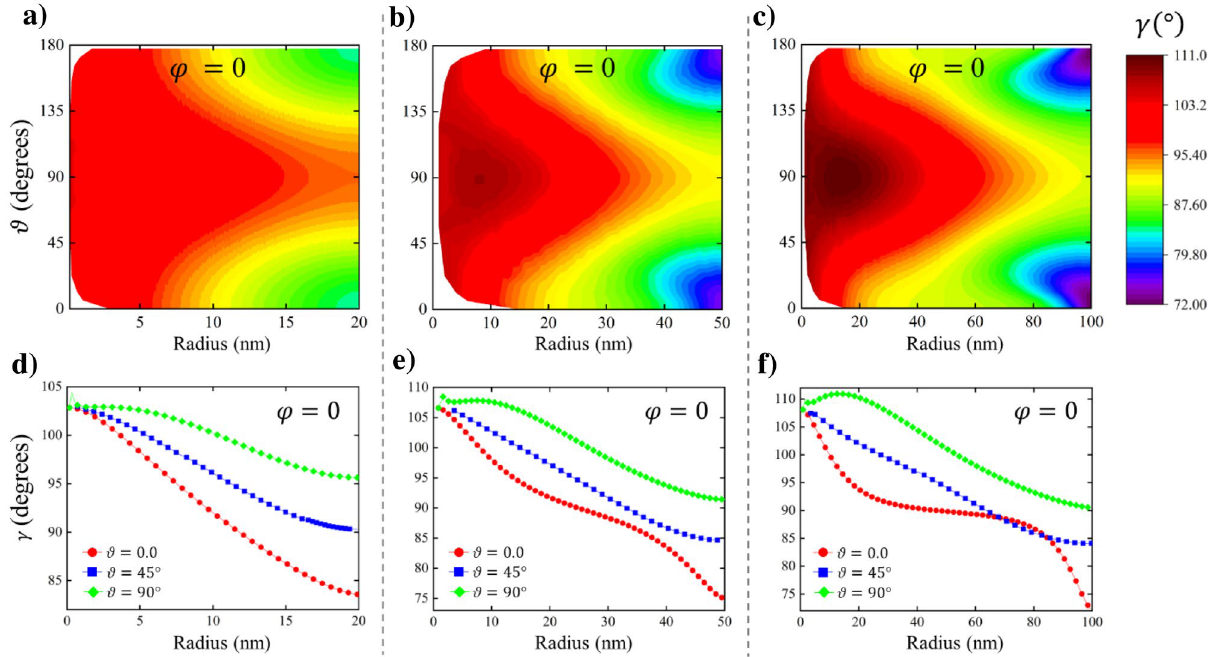
Figure 3. Helicity of a Bloch point. The helicity γ( r , ϑ) maps of the spherical magnetic nanoparticles of